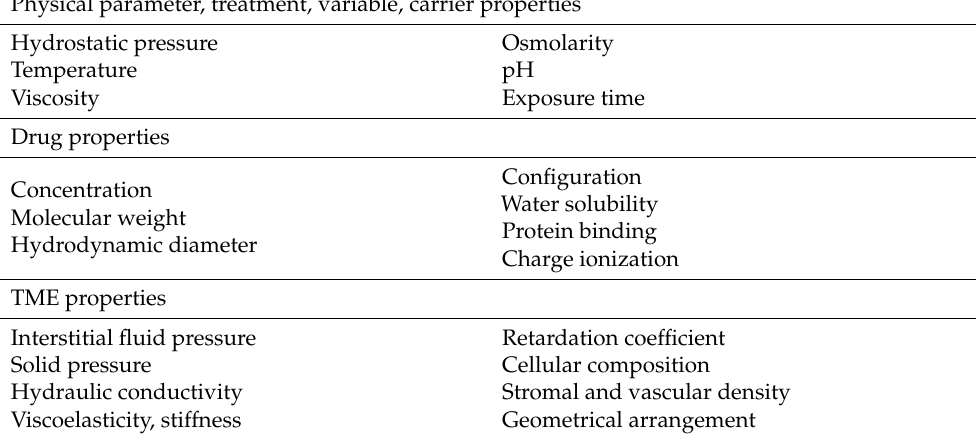
Table 1. An overview of relevant factors that affect tissue transport during intraperitoneal drug delivery